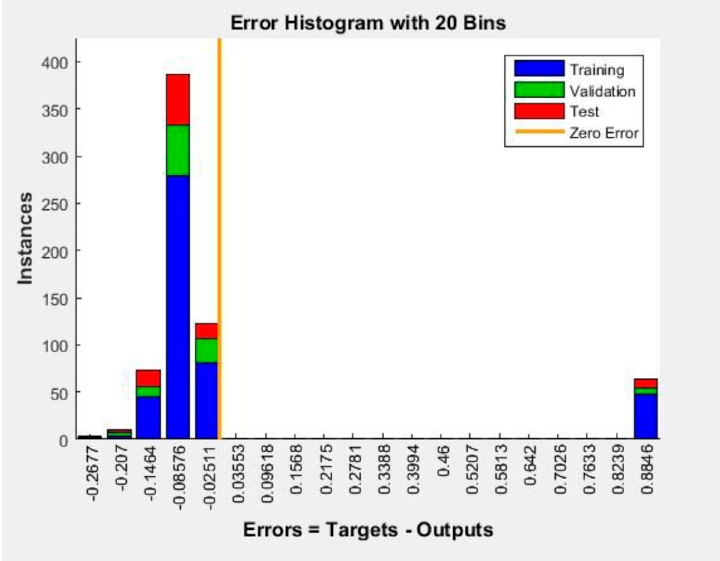
Figure 14. Histogram of errors made by the network using third-degree polynomial coefficients.